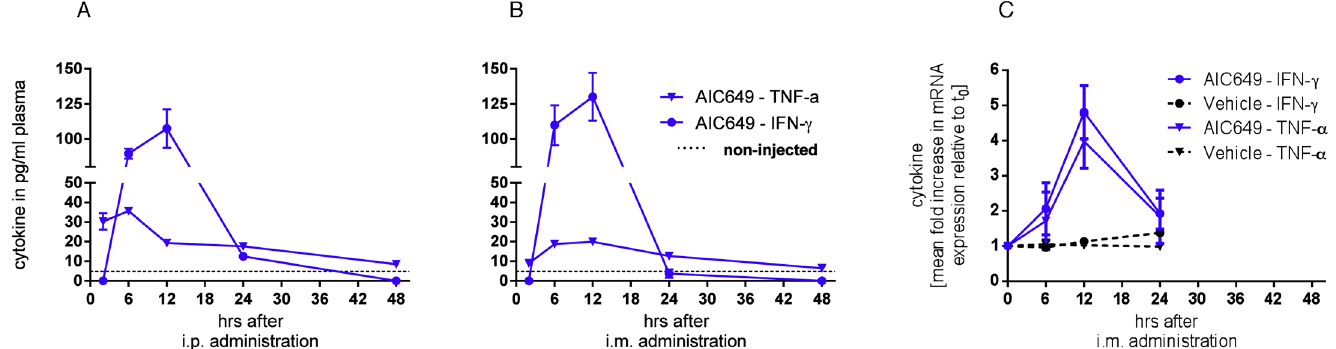
Fig 2. AIC649 induces similar cytokine release kinetics in mice and woodchucks. Three healthy BALB/c mice / time point were treated once with 1 x 10 5 U AIC649 i.p. (A) or 2.5 x 10 4 U AIC649 i.m. (B). Mice were sacrificed at the indicated time points and plasma samples were pooled. The pooled plasma samples were subjected to duplicate cytokine determination. Plasma samples from non-injected mice were used as controls. Given are the means +/- SD. (C): Three healthy woodchucks were treated once with 3.9 x 10 6 U AIC649 /ml or vehicle. Blood was drawn at the indicated time points and subjected to determination of cytokine transcript levels. Results are given as mean fold change relative to pre-treatment (t = 0) levels +/- SD.